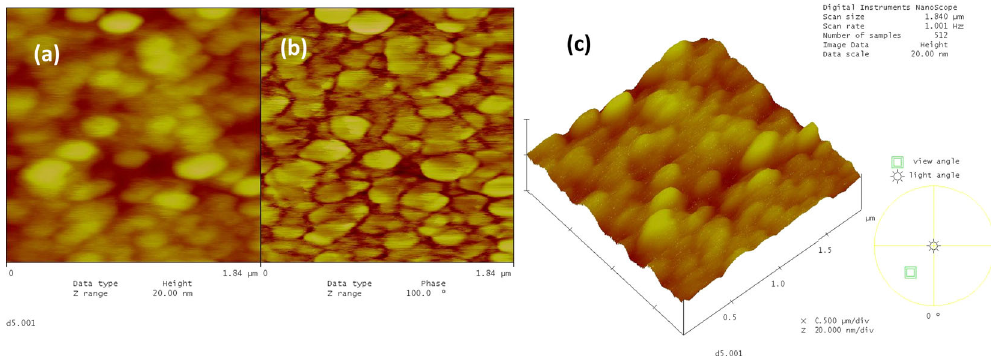
Fig. 3 The AFM images of the sericin fi lm on glass substrate, ( a ) 2-dim. topographical, ( b ) phase, and ( c ) 3-dim. topographical images, 1.84 × 1.84 μ m.